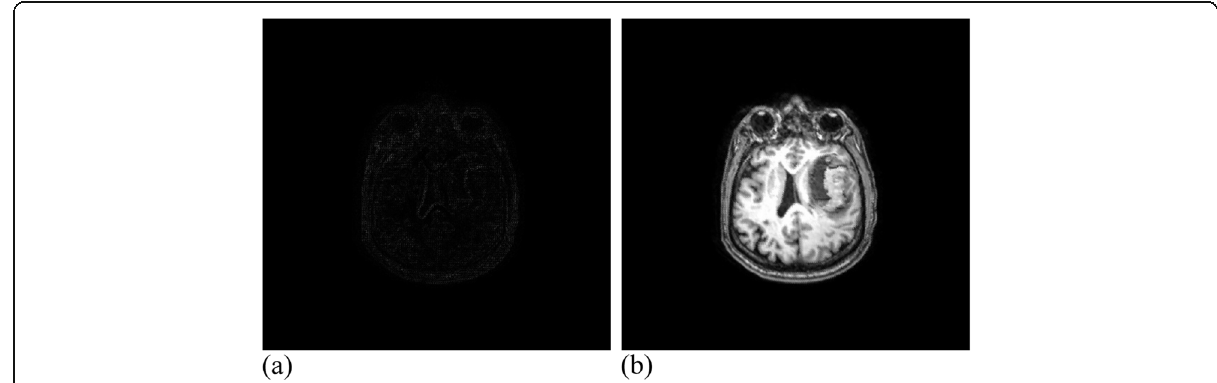
Fig. 12 MRI data after registration. ( a ): Difference between MRI reference image and registration image; ( b ): MRI registration